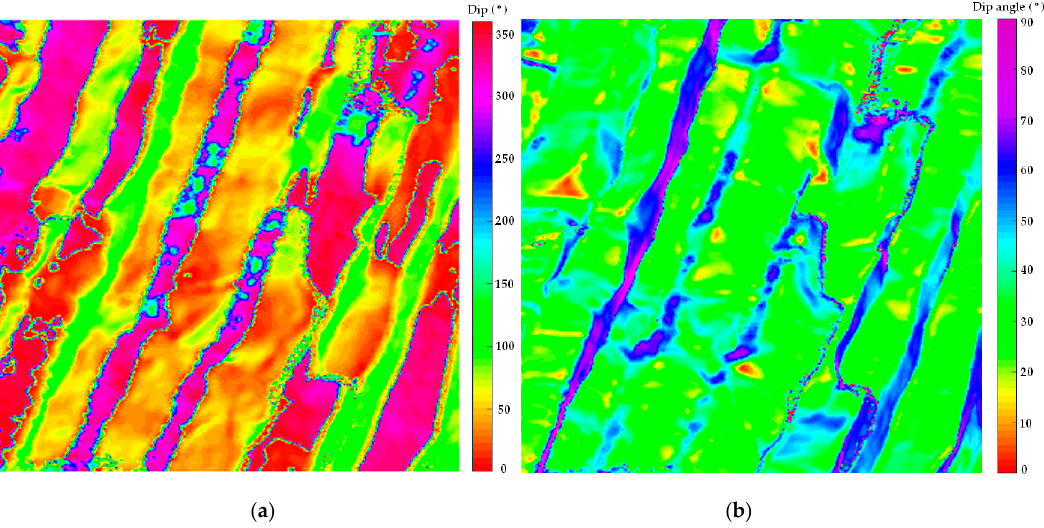
Figure 16. The 2D visualization of attitudes for a digital image: ( a ) The 2D visualization of dips in the image; ( b ) The 2D visualization of dip angles in the image.